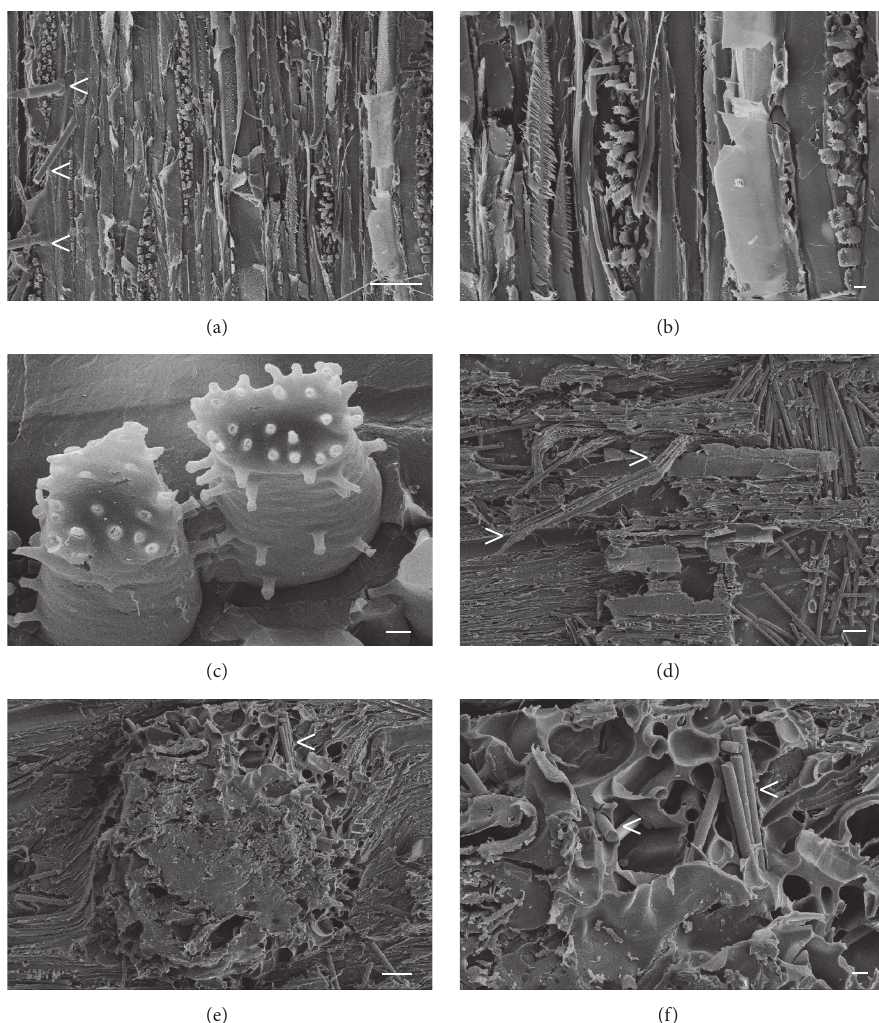
Figure 11: Fracture surfaces of a laminated birch wood composite bonded with a single component polyurethane adhesive containing 5.5% w/w milled (60 mesh) glass-fibre: (a) fractured wood surface showing pull-out and fracture of glass-fibre (arrowed left) and wood cells; pull-out of adhesive from ray cells; and adhesive that partially covers the wood surface (scale bar = 100 𝜇 m); (b-c) higher magnification photographs [from (a)] showing fracture of wood cells and pull-out of adhesive from the lumens of individual ray cells (scale bars are 10 𝜇 m (b) and 1 𝜇 m (c)); (d) fractured wood surface showing residual adhesive, pull-out of bundles of fibres (arrowed left and centre) and presence of numerous glass-fibre strands (right) (scale bar = 100 𝜇 m); (e-f) fractured column of adhesive containing embedded glass-fibre that provided through-reinforcement to the composite (arrowed top right of centre in (e), and centre and right in (f)). Note the fracture and distortion of the adhesive column and the distortion of the adjacent wood (scale bars are 100 𝜇 m (e) and 20 𝜇 m (f)).